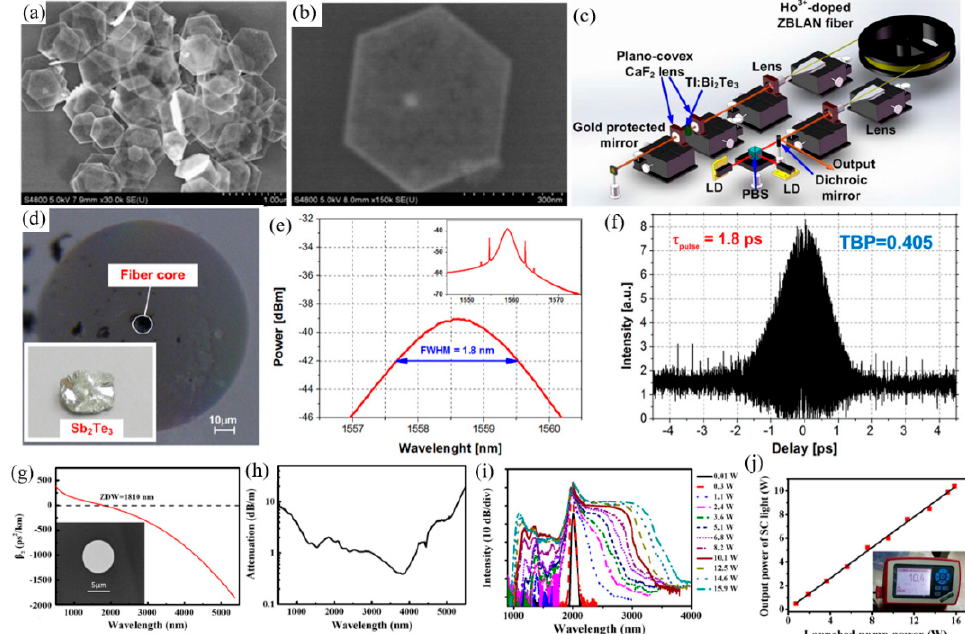
Figure 8. ( a ) Lower and ( b ) higher magnification SEM images of Bi 2 Te 3 samples. ( c ) The device of passive Q-switched Ho 3+ -doped fiber laser based on the TI: Bi 2 Te 3 SA [210]. Copyright 2015 The Optical Society. ( d ) Morphology of Sb 2 Te 3 layers under atomic force microscope. The central wavelength of the emitted solitary light is 1558.6 nm. ( e ) Spectrum with indication of 3 dB bandwidth. Illustration: spectral record of the 30 nm span, ( f ) 1.8 ps pulse Autocorrelation [225]. Copyright 2014 American Institute of Physics. ( g ) Dispersion curve of the fluortellurate glass fiber, inset: photo of the end face of the fluortellurate glass fiber. ( h ) Loss curve of fluortellurate glass fiber. ( i ) Evolution trend